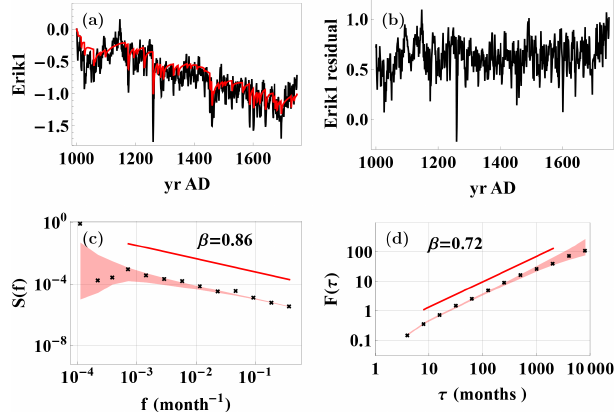
Figure 10. (a) The temperature from the ECHO-G control simula- tion. (b) PSD, (c) DFA2, and (d) WVA2 applied to the record. The shaded areas are the 95% confidence range for synthetic fGn with β estimated by PSD, DFA2 and WVA2. The β -values are estimated from the slopes of the straight lines and the range of scales used for estimation is indicated by the length and position of these line segments. The estimated β -values are indicated in the figure.